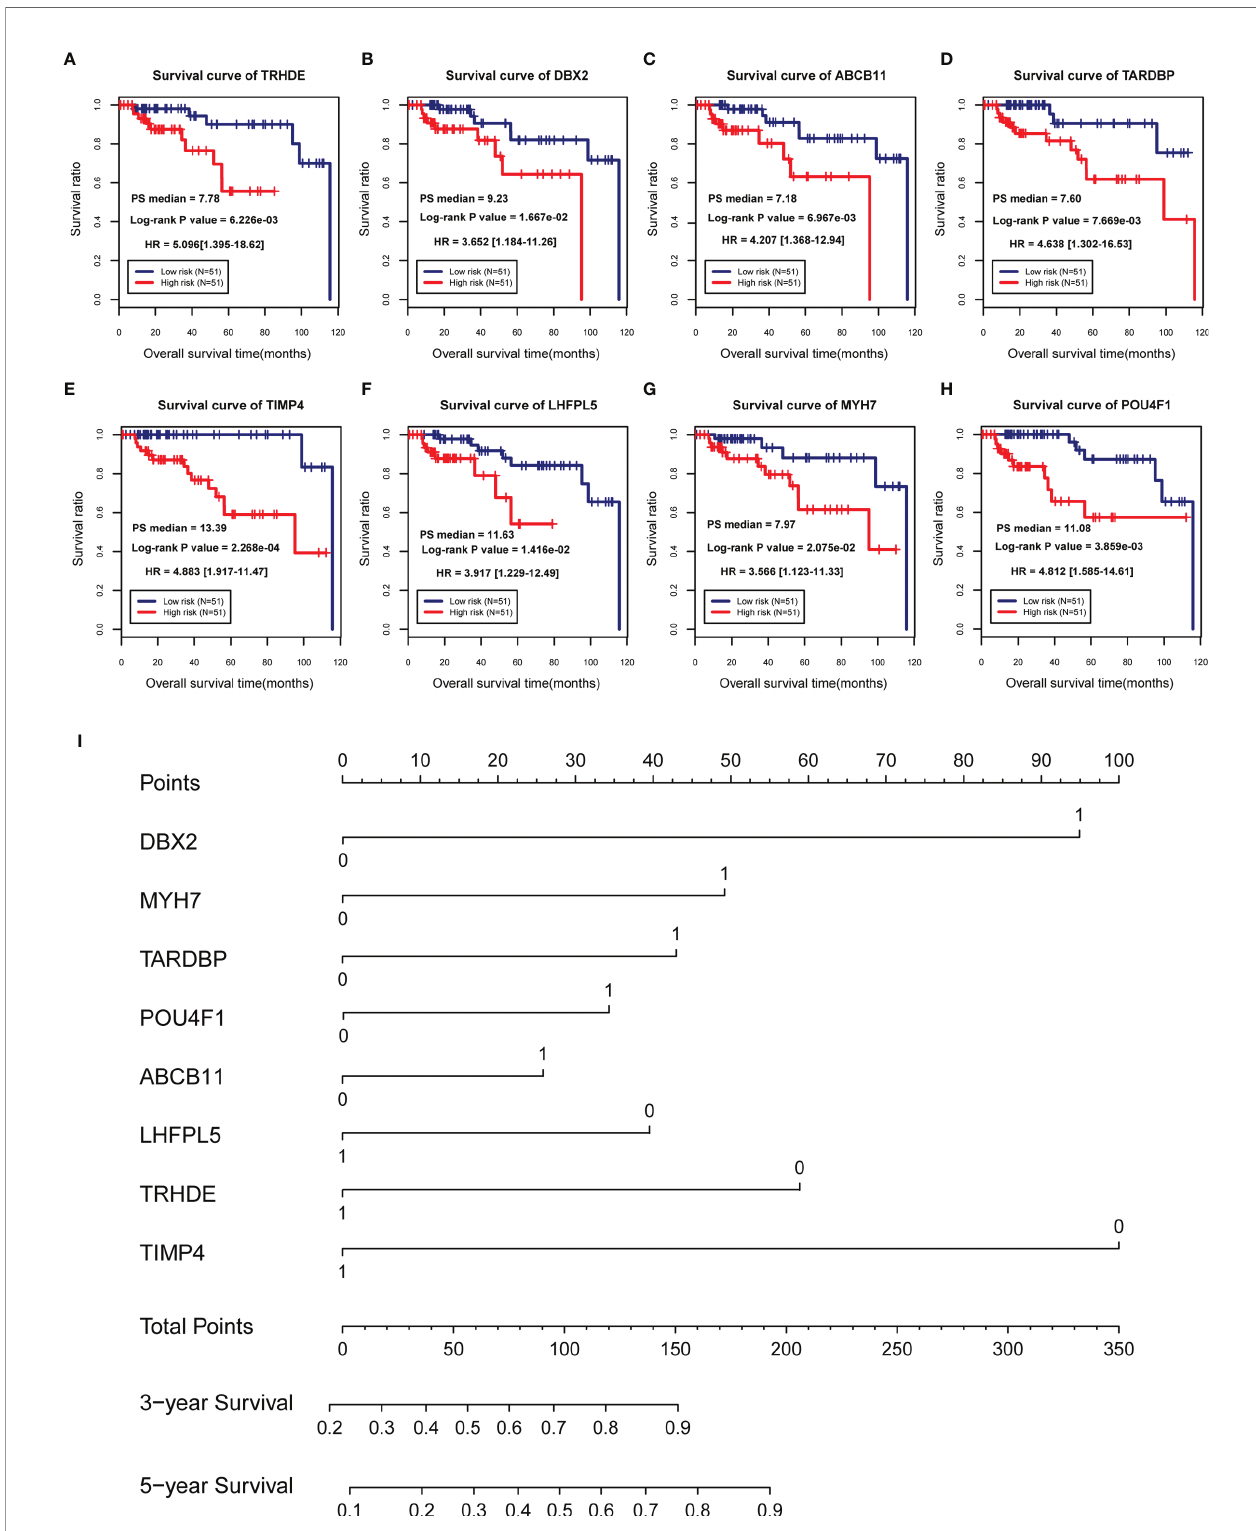
FIGURE 4 | Establishment of a prognostic model for TNBC patients. (A – H) Survival curves of patients with TNBC, divided into low-risk and high-risk groups, carrying known prognostic genes. (I) Nomogram for the overall survival of TNBC patients.